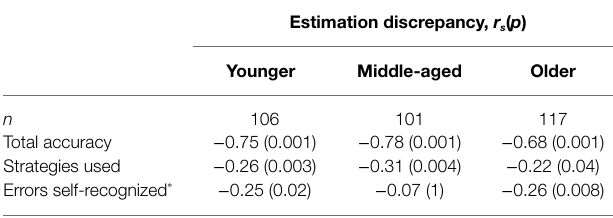
TABLE 4 | Correlations between estimation discrepancy and accuracy, number of strategies used, and self-recognition of errors in age